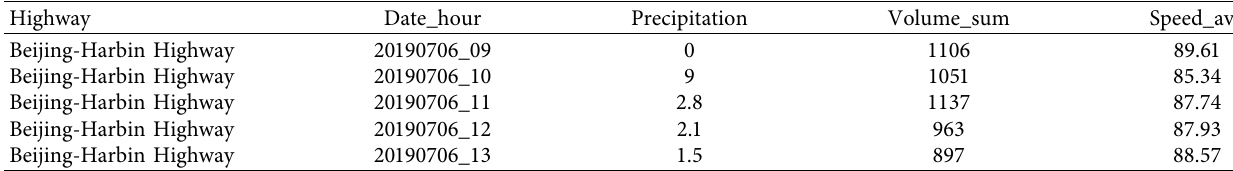
Table 3: Data format after spatiotemporal